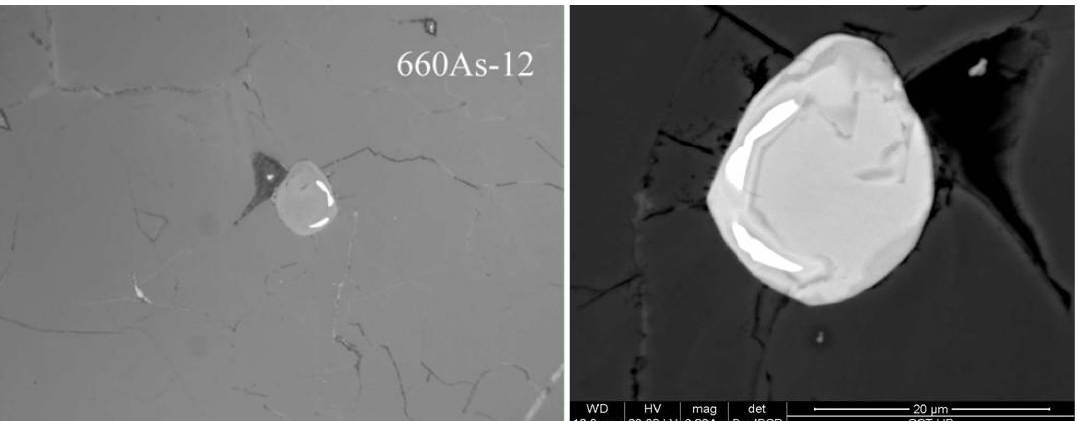
Figure 14 . Paragenetic assemblages of PGE oxide in the CHR-2 chromitite (optical and BSE images). 660As-12: Large grain of Ru-Ir oxide with impurities of Mn, Ni and As; the internal white patches are relicts of Os-rich